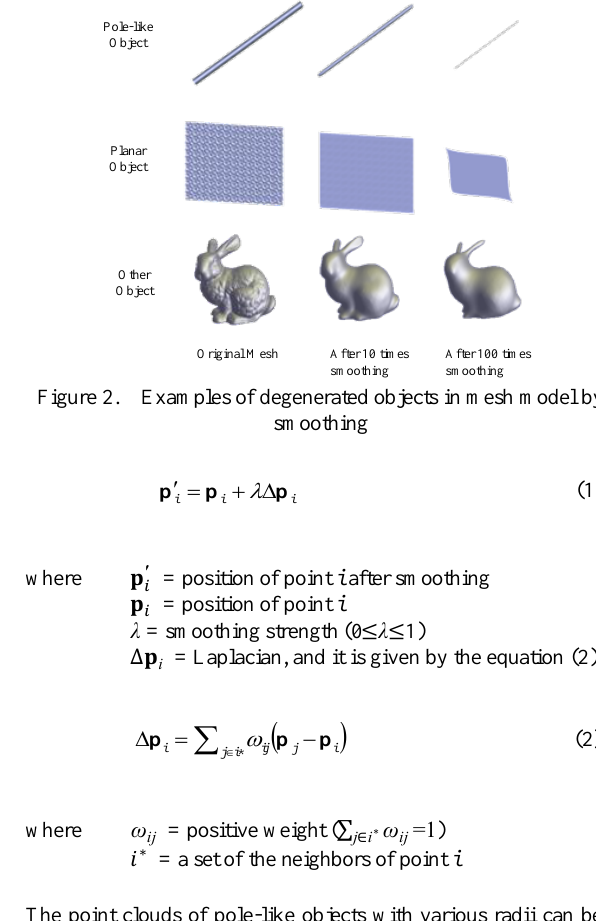
Pole-like Objects Recognition Method